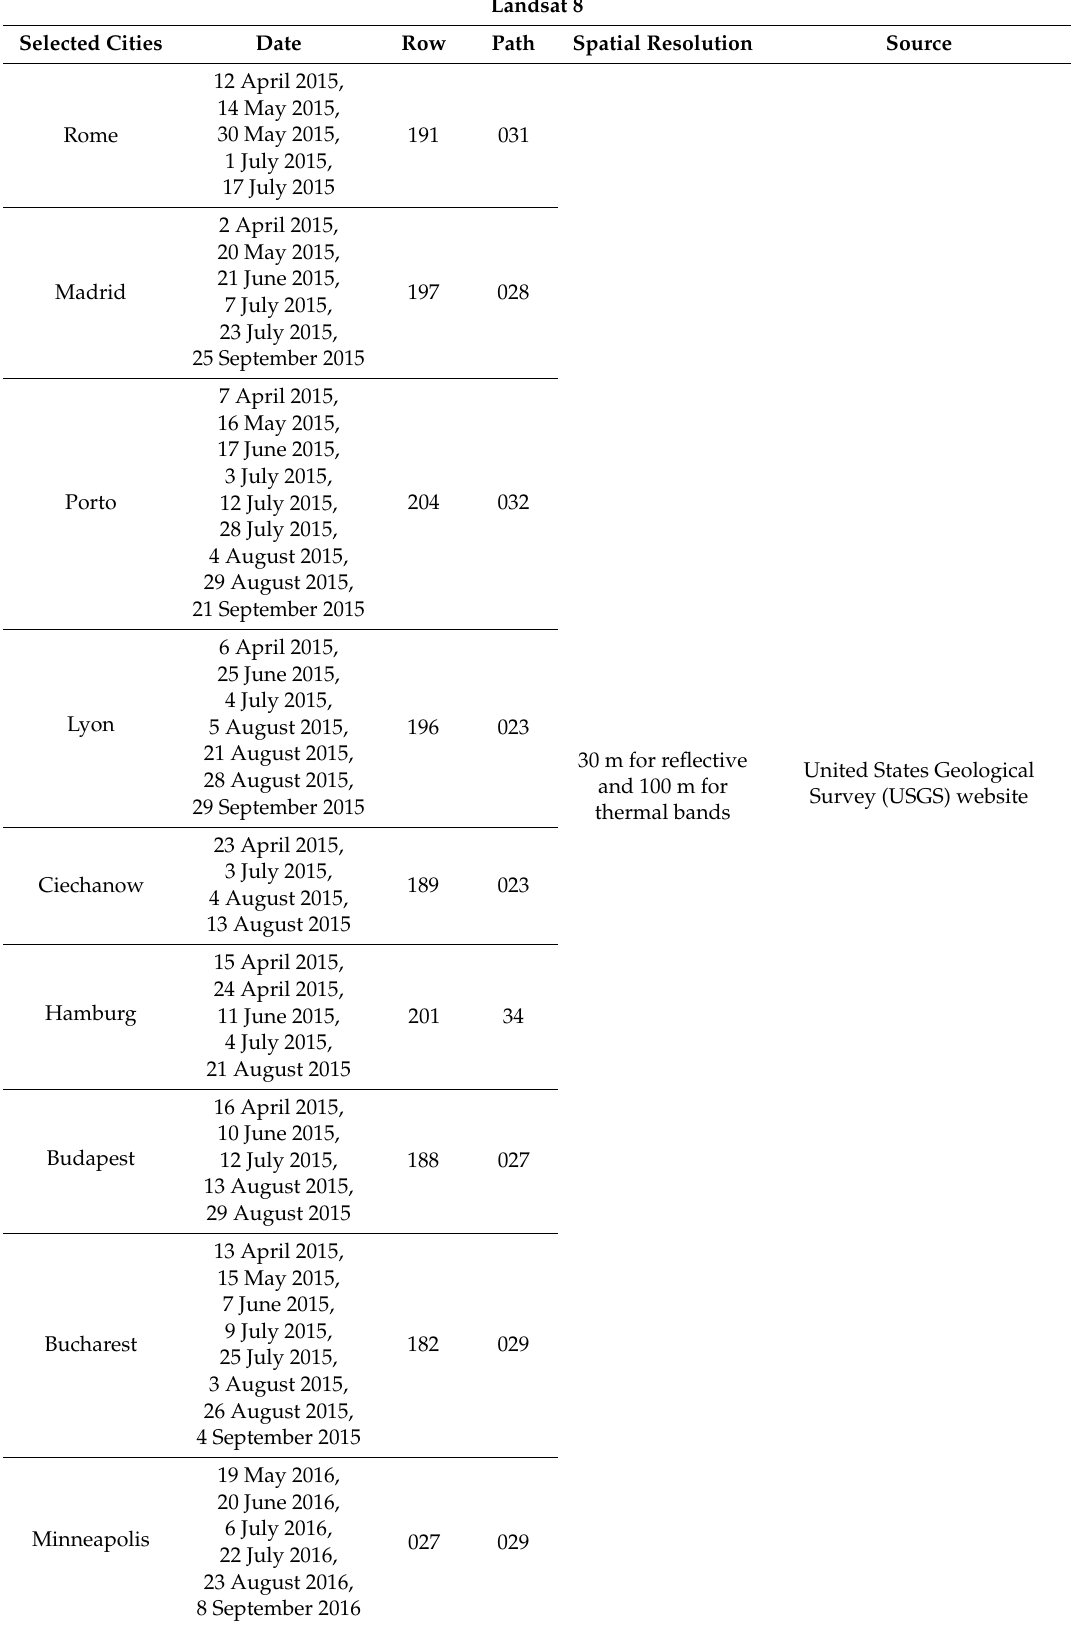
Table 2. Details of the data utilized in the study. Landsat